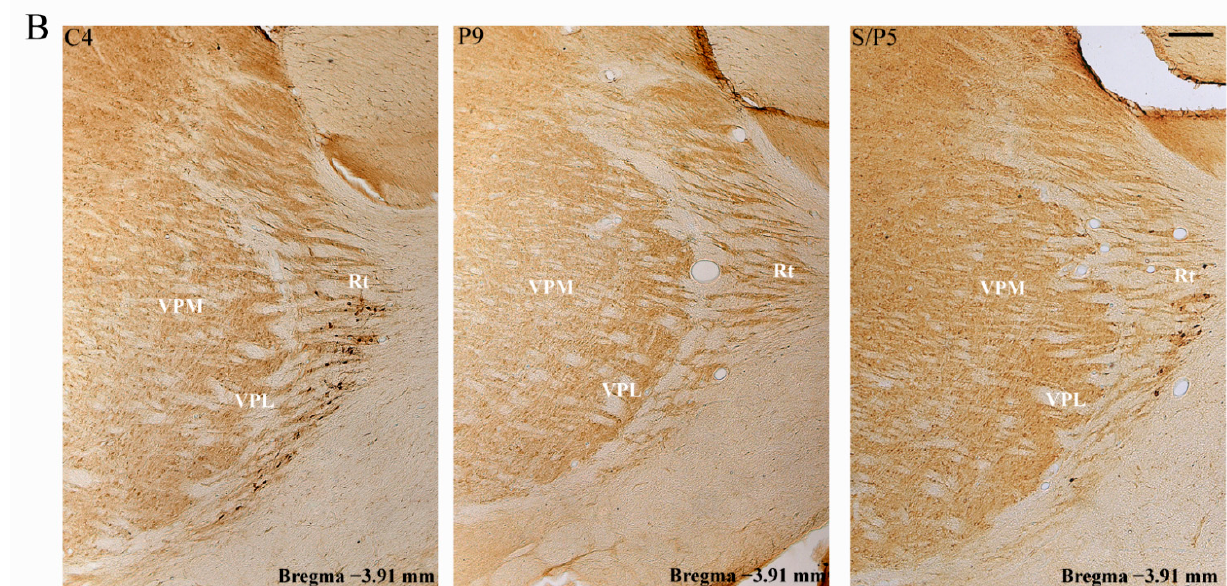
Figure 12. Individual examples of MAP2 and PSD-95 immunostaining alteration within RT in the distinct rat models of PD neuropathology. ( A ) The typical individual examples of MAP2 immunoreactivity within RT in the control rat (Control, C4), rat with PD cholinopathy (PPT lesion, P9), and hemiparkinsonian rat with PD cholinopathy (SNpc/PPT lesion, S/P5). Scale bar is 200 µ m. ( B ) The typical individual examples of PSD-95 immunoreactivity within RT in the control rat (Control, C4), rat with PD cholinopathy (PPT lesion, P9), and hemiparkinsonian rat with PD cholinopathy (SNpc/PPT lesion, S/P5). Rt—reticular nucleus; VPM—ventral posteromedial thalamic nucleus; VPL—ventral posterolateral thalamic nucleus; ic— internal capsule. Scale bar is 200 µ m. Whereas the partially increased MAP2 expression in RT of the rats with PD cholinopathy was followed by the suppression of PSD-95 expression, the enhanced MAP2 immunoreactivity in RT of the hemiparkinsonian rats with PD cholinopathy was followed by PSD-95 expression similar to control level.